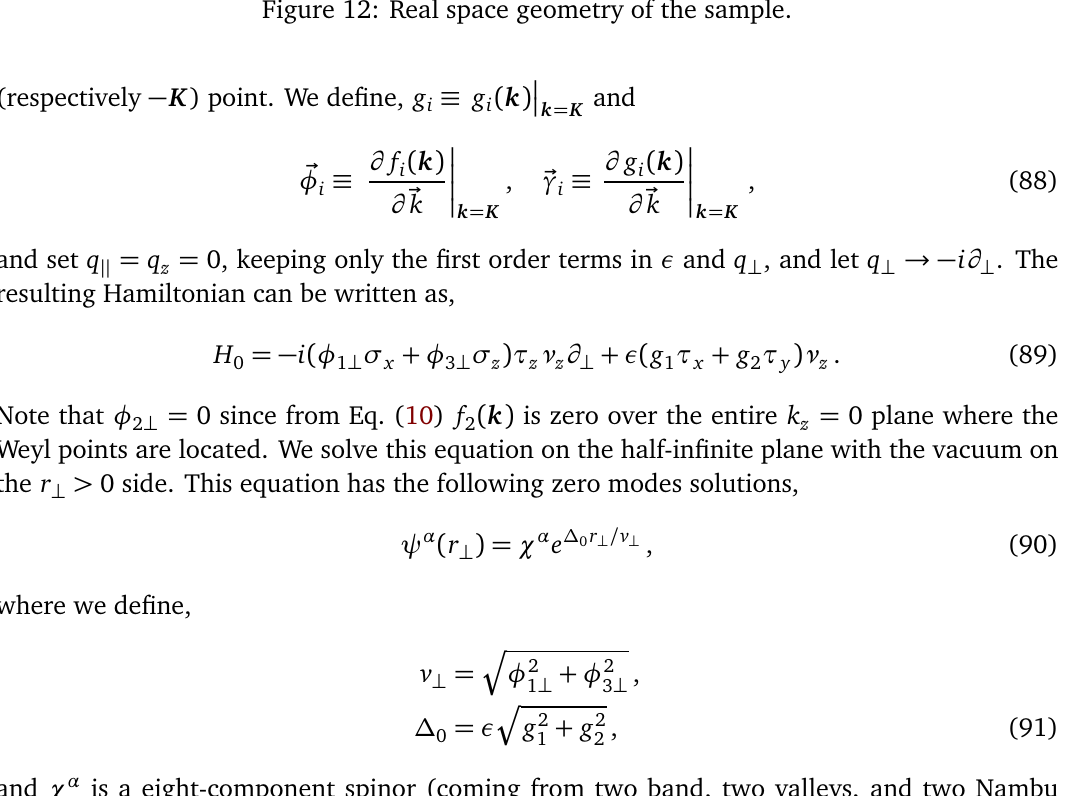
Figure 12: Real space geometry of the